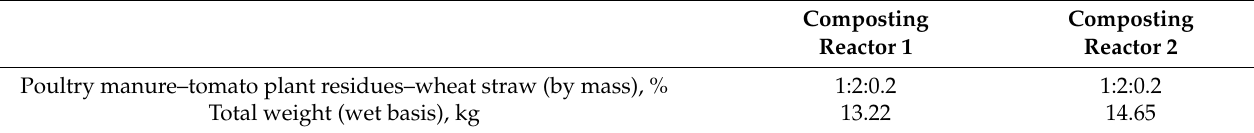
Table 2. Composition of the composting mixtures.